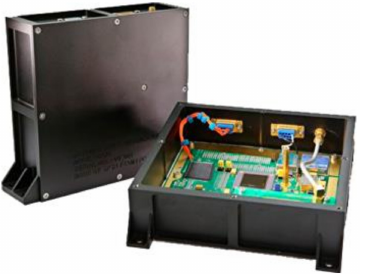
Figure 2. The first space-grade GPS receiver in